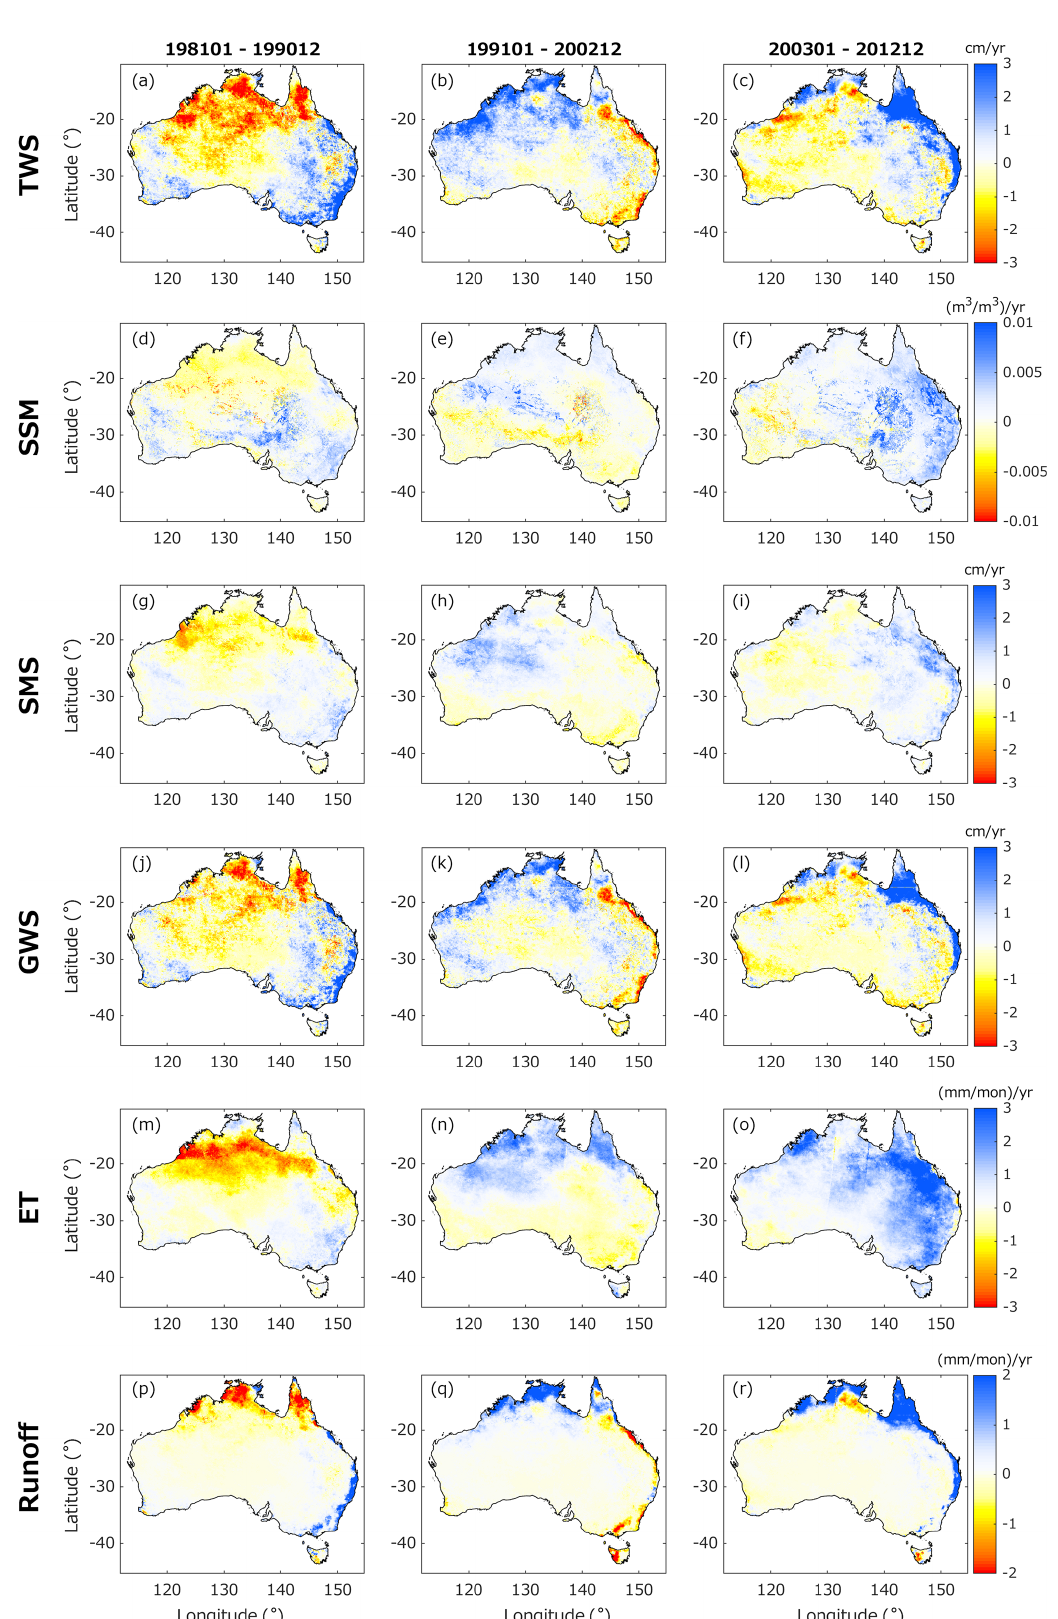
Figure 8. Similar to Fig. 7 but the trends are associated with three different periods, i.e., 1981–1990 (a, d, g, j, m, p) , 1991– 2002 (b, n, h, k, n, q) , and 2003–2012 (c, f, i, l, o, r)